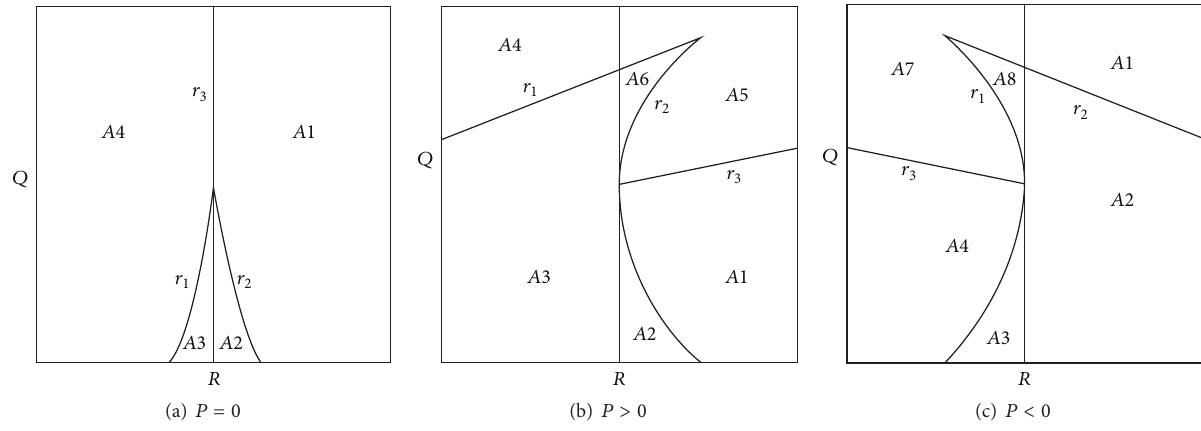
Figure 1: Partitions of the two-dimensional 𝑄 - 𝑅 diagrams at different 𝑃 values [14,